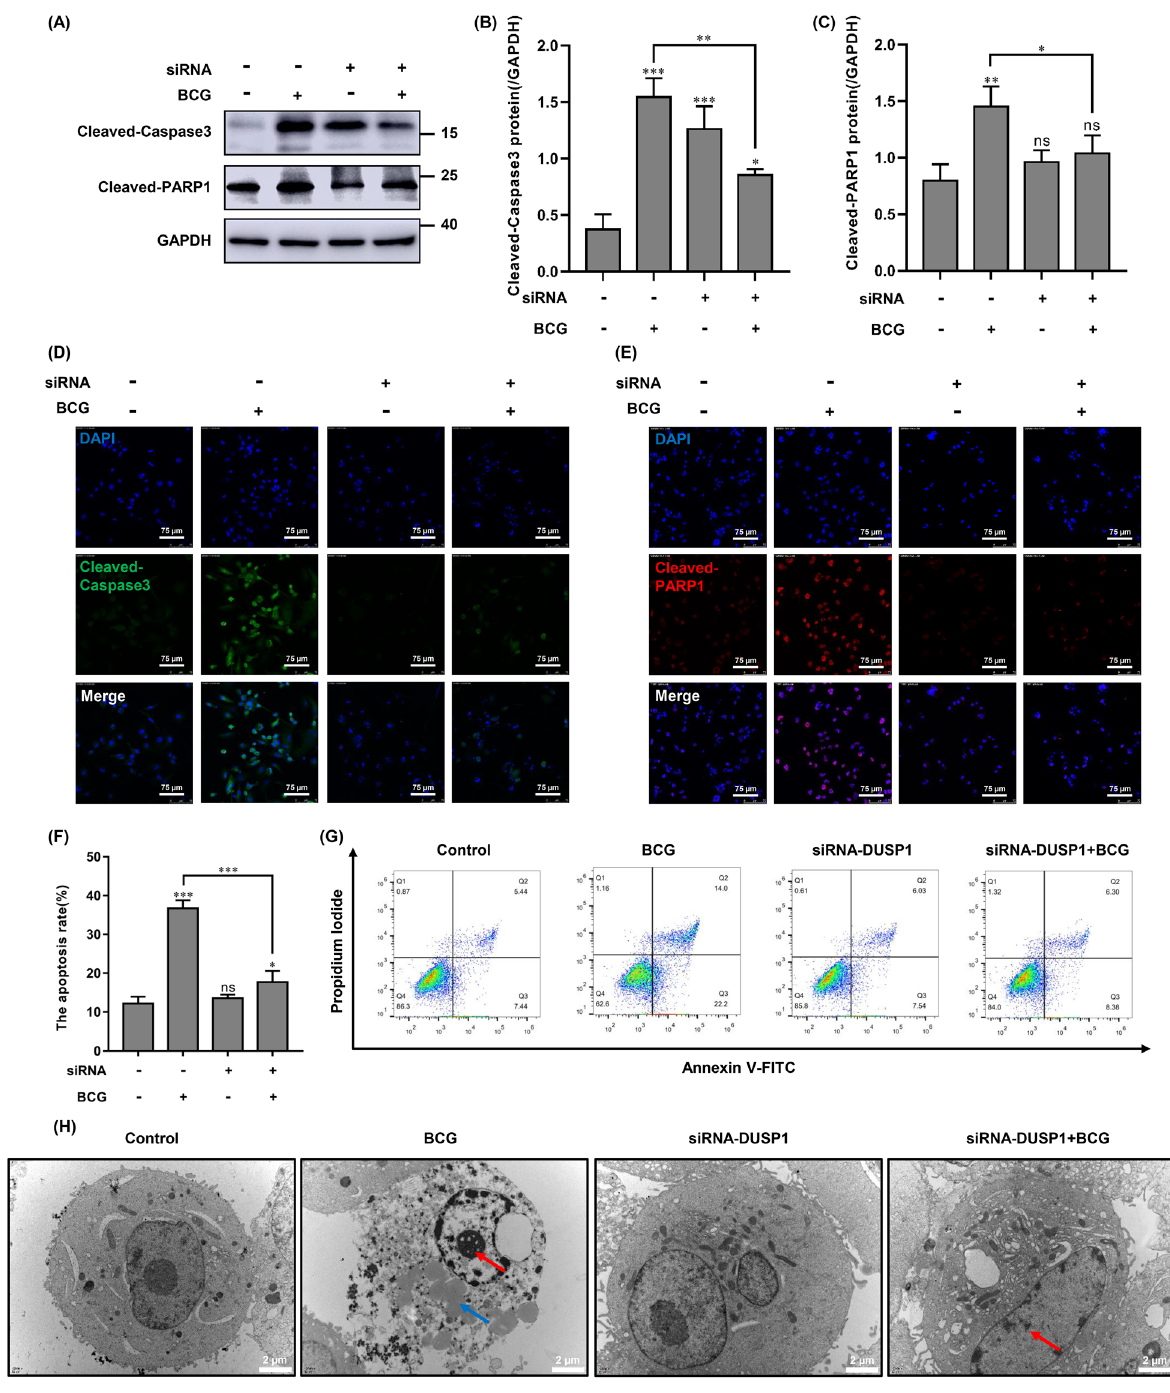
Figure 3. Effect of knockdown of DUSP1 on BCG-induced apoptosis in macrophages. ( A – C ) THP-1 cells were transfected with siRNA-NC (negative control) or siRNA-DUSP1 for 24 h and then infected with BCG and cultured for 6 h. Cleaved-Caspase3 and Cleaved-PARP1 protein expression was detected by western blotting. ( D , E ) Knockdown of DUSP1 combined with BCG infection were detected by immunofluorescence technique for Cleaved-Caspase3 and Cleaved-PARP1 expression levels. Scale bar, 75 μm. ( F , G ) THP-1 cells were transfected with siRNA-NC (negative control) or siRNA-DUSP1 for 24 h and then infected with BCG and cultured for 6 h, apoptosis was determined by Annexin V/PI staining using FCS analysis. ( H ) THP-1 cells were transfected with siRNA-NC or siRNA-DUSP1 for 24 h and then infected with BCG and cultured for 6 h, the morphological effects of DUSP1 on apoptosis of BCG-infected THP-1 cells were observed by transmission electron microscopy, the blue arrow denotes the cytoplasmic vacuole of apoptotic cells, while the red arrow indicates the nucleus. Scale bar, 2 μm. All data are represented as mean ± SD (n = 3). (* p < 0.05, ** p < 0.01, *** p <